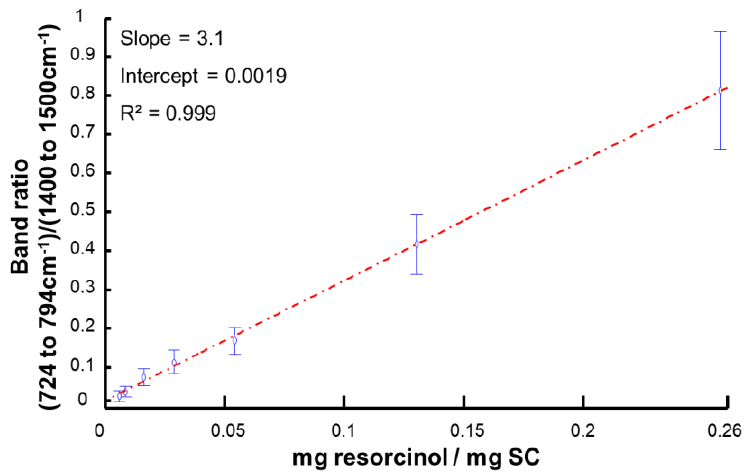
Figure 7. Band ratio of the AUC of the C–C band of the aromatic resorcinol ring [724–794 cm − 1 ] and the C–H band of protein/lipids of the SC [1400–1500 cm − 1 ] regressed against resorcinol content in SC expressed as mg resorcinol/mg SC.